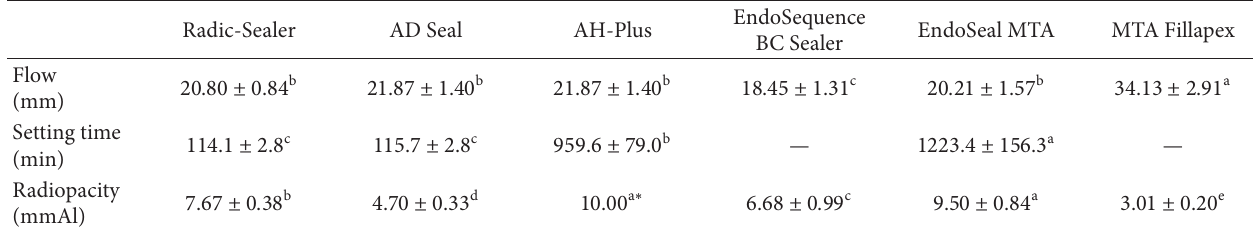
Table 3: The flow (mm), setting time (min), and radiopacity (mmAl thickness) of tested sealers (mean ± standard deviation). Radic-Sealer